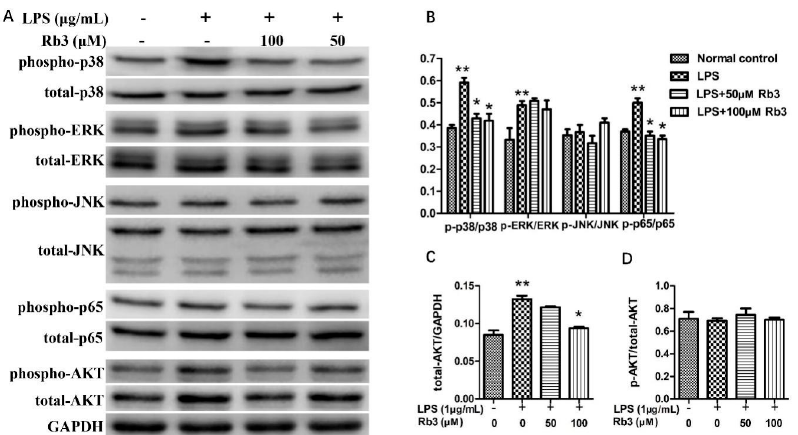
Figure 4. Rb3 suppresses inflammatory activation of p38 MAPK, AKT, and NF- κ B. HPLCs were pretreated with Rb3 for 60 min and stimulated with P. gingivalis LPS for 30 min. ( A – D ) Detection and quantification of proteins expression by Western blot and Image J analysis. Data were presented as means ± SE (n = 3). SE, standard error. * p < 0.05 compared with LPS stimulation only group. ** p < 0.05 compared with normal control.